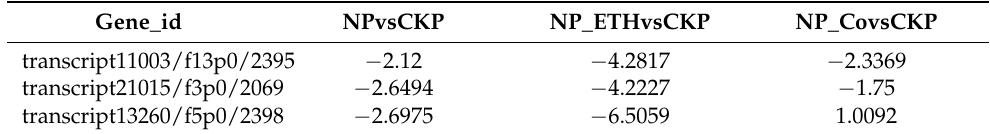
Table 2. Significant of DEGs under P treatment with the addition of ethephon or CoCl 2